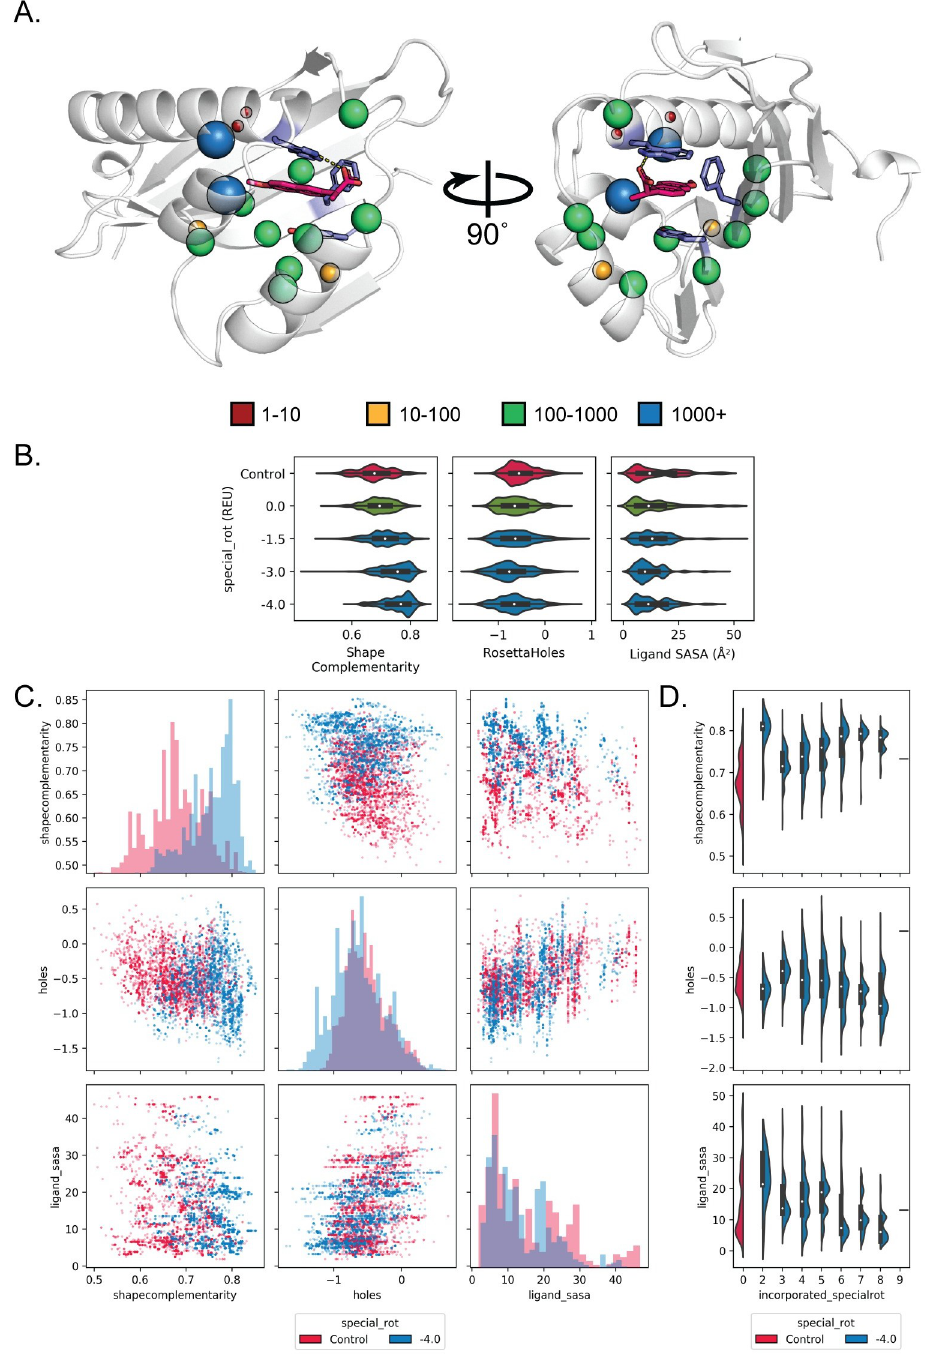
Fig 6. Composite binding sites combined with complementary rotamers improve design quality metrics for naproxen. A. Spheres indicate the number of complementary rotamers accepted per position to design the context of a composite binding site composed of tryptophan, tyrosine, and phenylalanine (purple) for naproxen (hot pink) placed in the scaffold protein PDBID 2RCD. B. Violin plots depict the distribution of values obtained for shape complementarity, RosettaHoles, and ligands SASA metrics after design using complementary rotamers with special_rot bonus values (blue; distributions after merely adding complementary rotamers with no special_rot bonus are shown in green). Control designs (red) were generated using the unmodified Packer. C. Scatterplots comparing different design metrics for individual designs (dots), showing simultaneous improvement in shape complementarity and binding site packing with the application of complementary rotamers (blue, special_rot bonus of -4.0